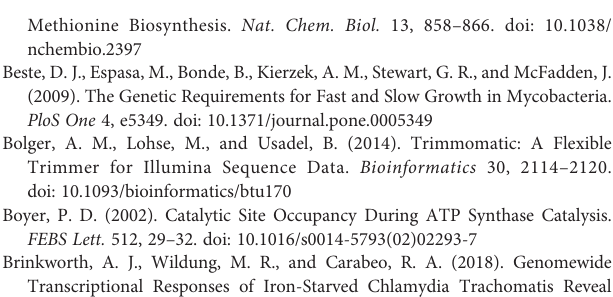
Supplementary Figure S1 | Volcano plot showing signi fi cant changes in gene expression in ML48 and ML96 when compared to freshly harvested M. leprae from mouse footpad (MFP5). No difference in gene expression levels were observed between ML48 and ML96. Supplementary Table S1 | Formulation of NHDP axenic medium for in vitro maintenance of M. leprae . Supplementary Table S2 | Potential homologs for twelve highly expressed M. leprae hypothetical